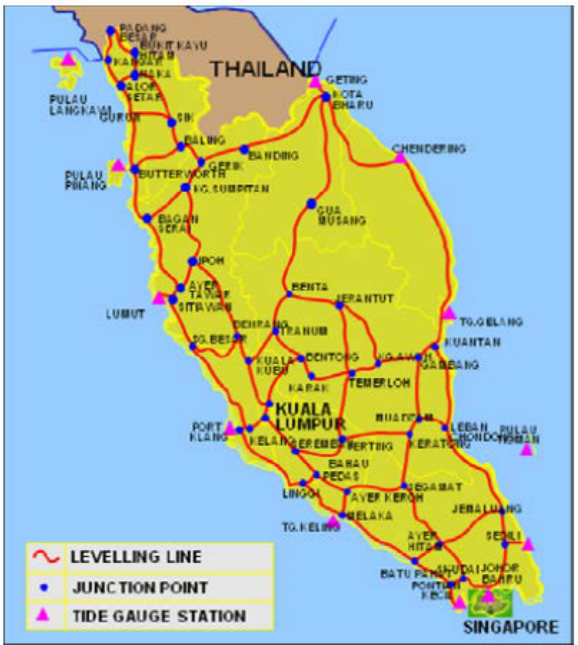
Figure 4. Precise Levelling Network (Country Report,